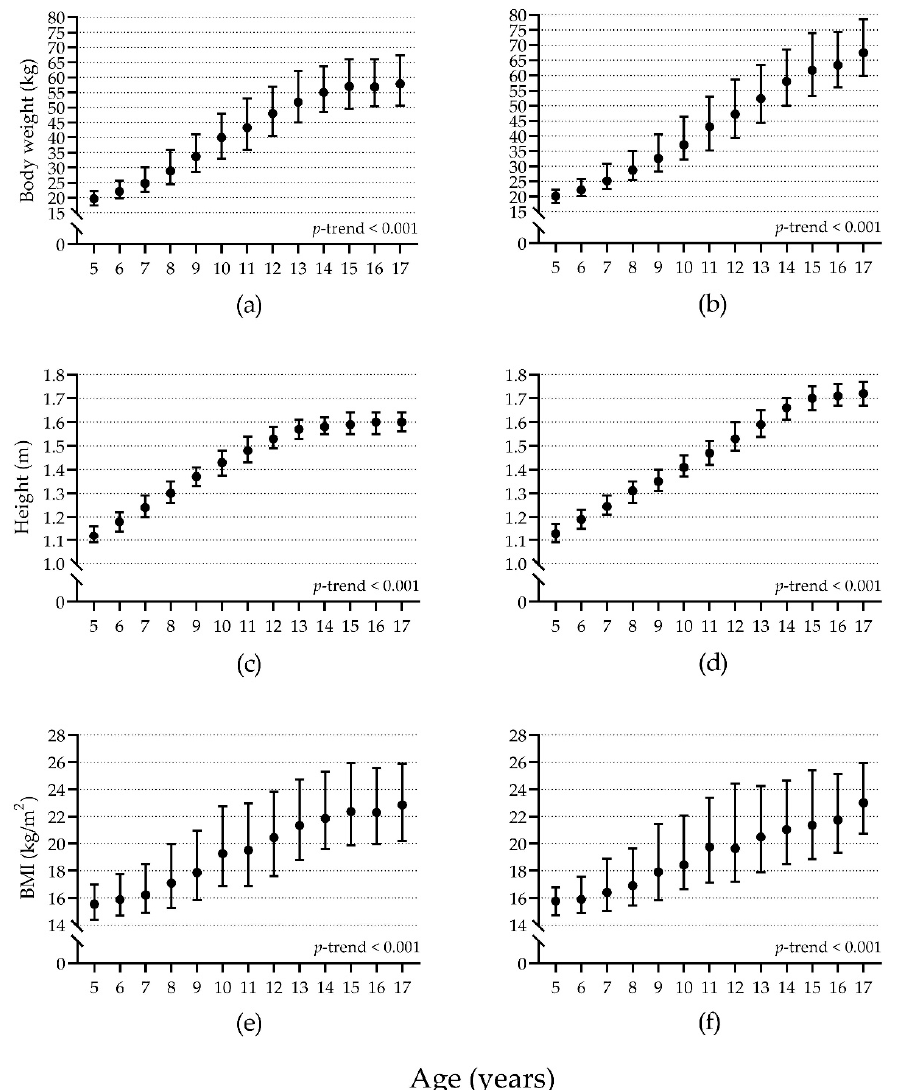
Figure 2. Body weight ( a , b ), height ( c , d ), and BMI ( e , f ) comparison by age in girls ( a , c , e ) ( n = 6998) and boys ( b , d , f ) ( n = 5981). Solid circles represent the median values; whiskers represent the 25th and 75th percentiles. p -trend calculated with the Kruskal-Wallis H test. BMI: Body mass index.